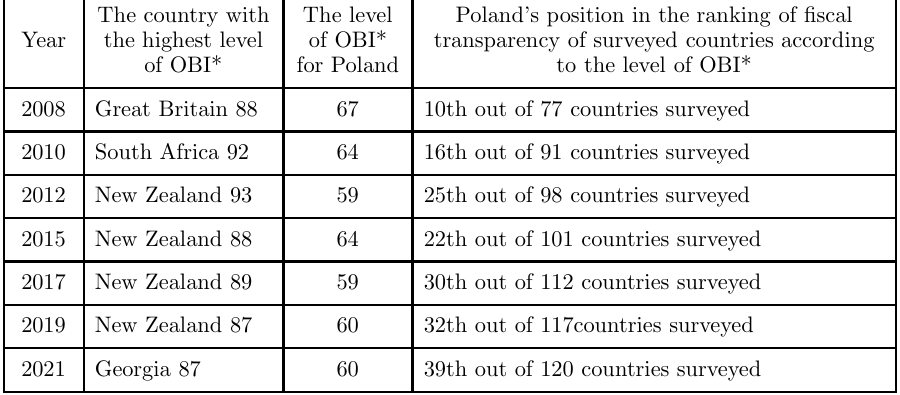
Level of transparency, oversight and participation in the creation of the state budget – Poland’s position in the ranking of assessed countries during the period under review The country with The level Poland’s position in the ranking of fiscal Year the highest level of OBI* transparency of surveyed countries according of OBI* for Poland to the level of OBI* 2008 Great Britain 88 67 10th out of 77 countries surveyed 64 16th out of 91 countries surveyed 25th out of 98 countries surveyed 22th out of 101 countries surveyed 30th out of 112 countries surveyed 32th out of 117countries